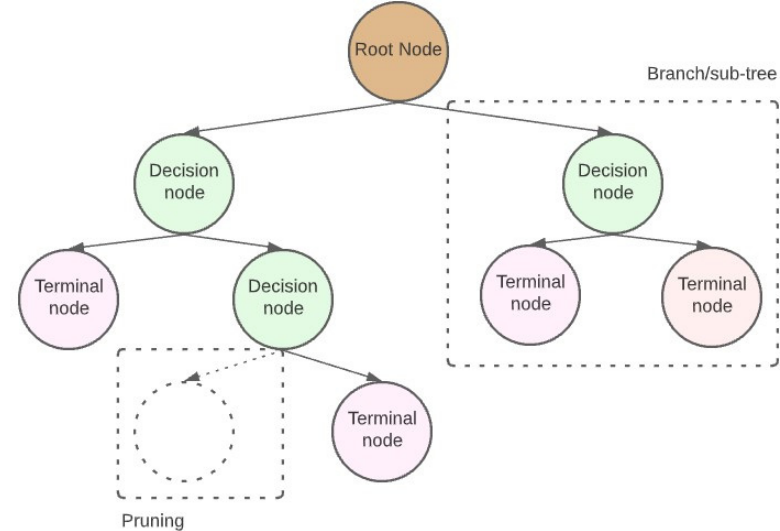
Figure 5. Decision Tree approach.